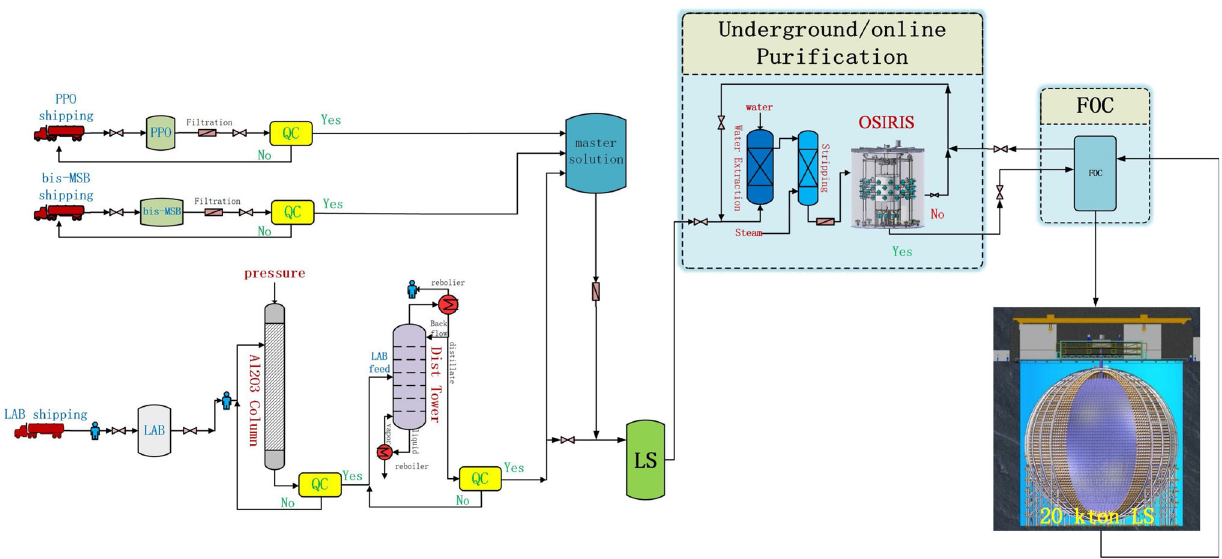
Fig. 1 Layout of the JUNO scintillator system including four purifi- cation stages (Al 2 O 3 column, distillation, water extraction, steam strip- ping) as well as storage and mixing tanks. OSIRIS is located as the last